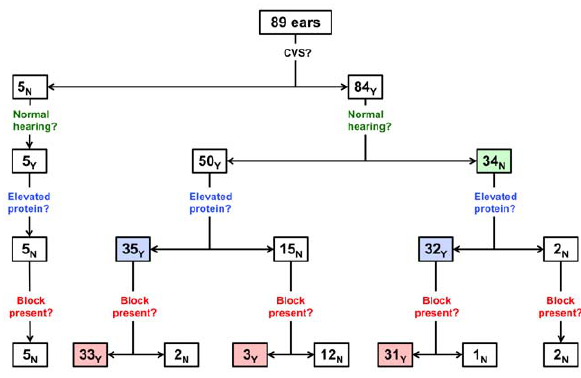
Figure 1. Features of normal hearing and hearing loss ears.